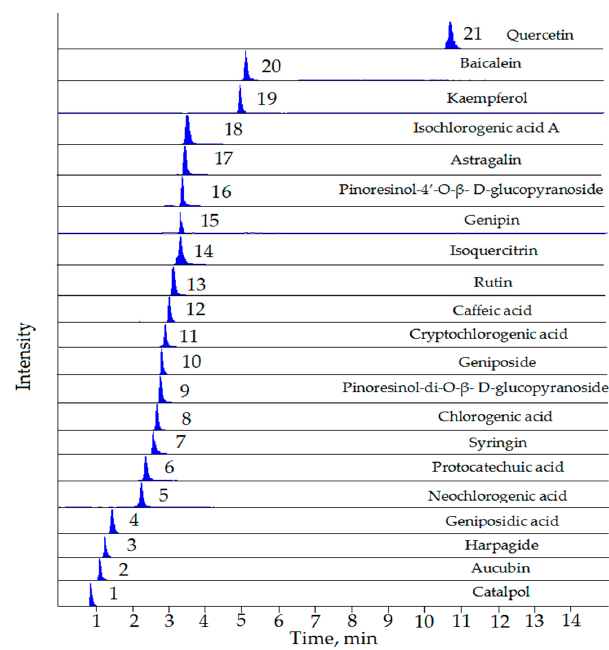
Figure 1. Representative extract ions chromatograms (XIC) of multiple-reaction monitoring (MRM) chromatograms of the 21 investigated compounds.